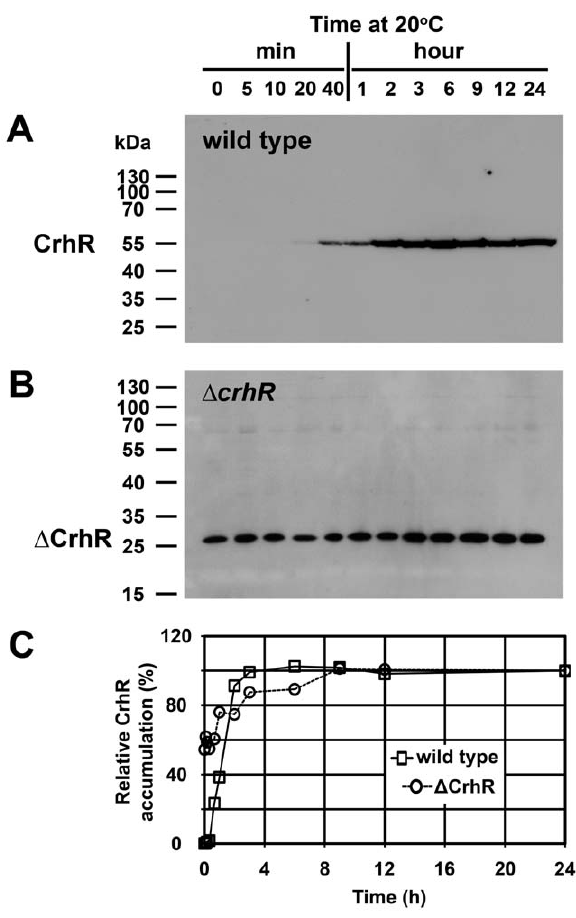
Figure 3. Time course of CrhR protein accumulation. CrhR in soluble proteins extracted from an aliquot of the cells used in Figure 2 was detected with an anti-CrhR antibody. ( A ) Wild type Synechocystis . ( B ) D crhR mutant. ( C ) Quantification of CrhR protein levels. Relative CrhR and D CrhR protein levels are indicated, normalized with respect to those present at 24 h, as described in Figure 1. Open circles, D crhR ; open boxes, wild type. doi:10.1371/journal.pone.0048683.g003 plates containing 10 mM Tricine pH 8.0 and 0.3% sodium thiosulphate at a light intensity of 50 m mol photons m 2 2 s 2 1 . For